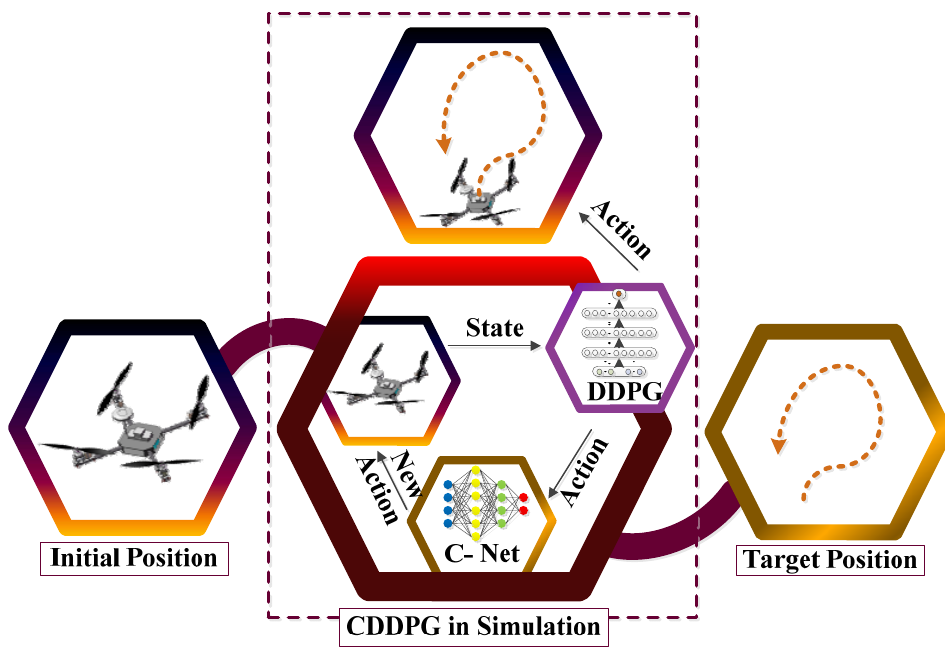
Figure 1. Principle of CDDPG algorithm.